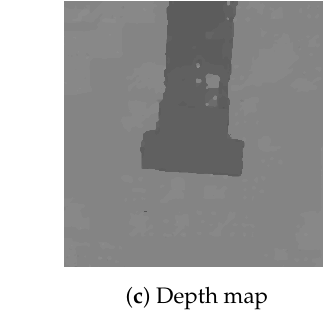
Figure 7. Exemplary light-field image file (close focal point and far away focal point of the same scene and object distance) and corresponding depth map during the calibration process of the Lytro LF. ( a ) Shows the RGB image focused on the object plane, whereas ( b ) is focused on the calibration board. ( c ) Contains the corresponding depth map indicating the object distances.